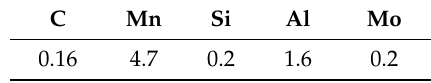
Table 1. Chemical composition of analyzed steel